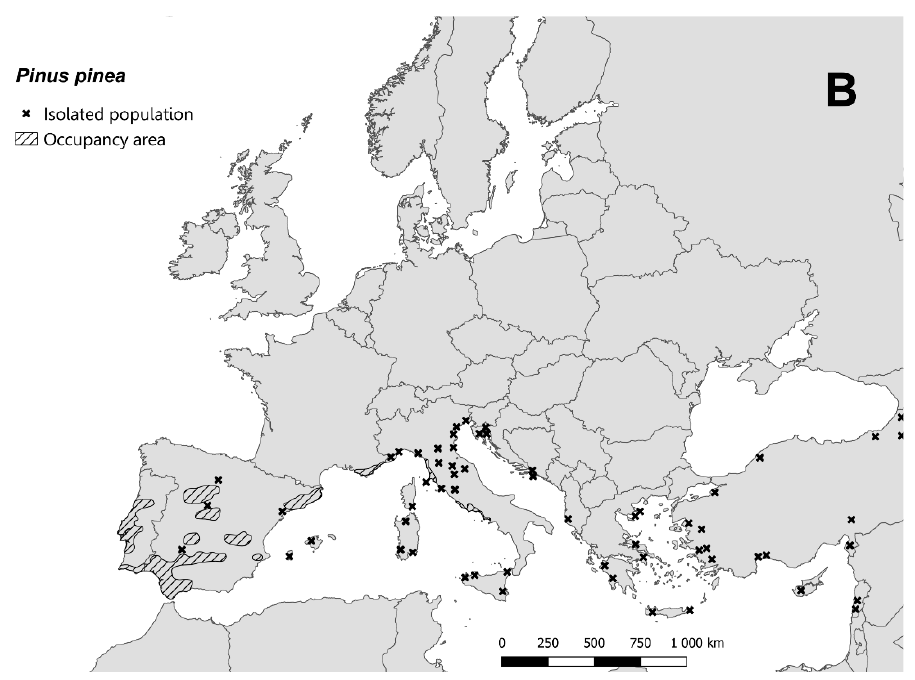
Figure 5. Distribution of ( A ) Pinus pinaster and ( B ) Pinus pinea in Europe following Caudullo et al.